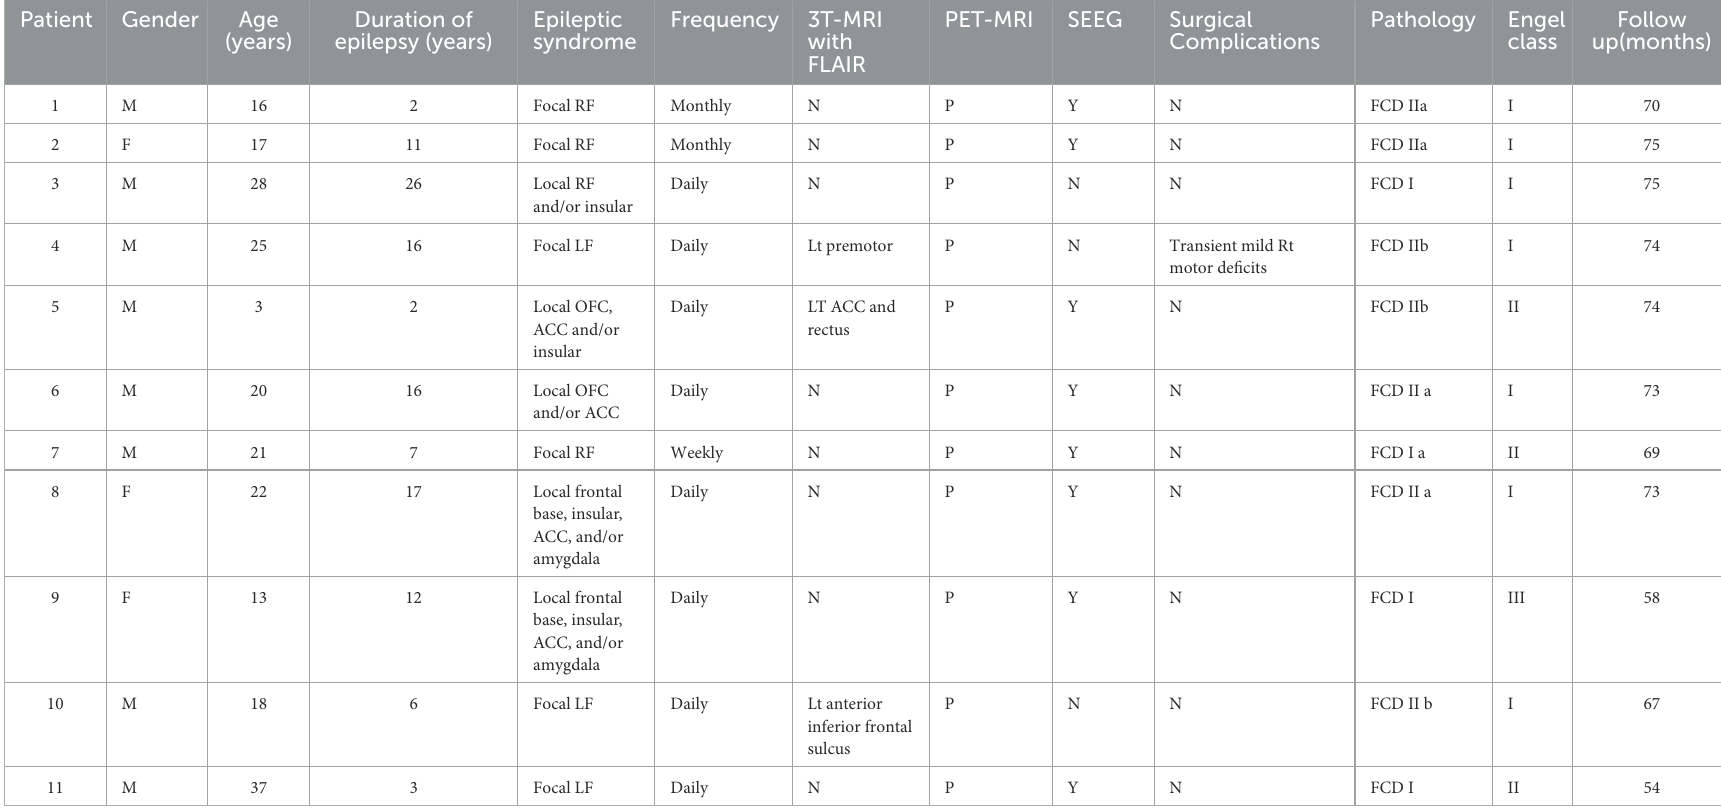
TABLE 3 Demographic features and clinical manifestations of the NS